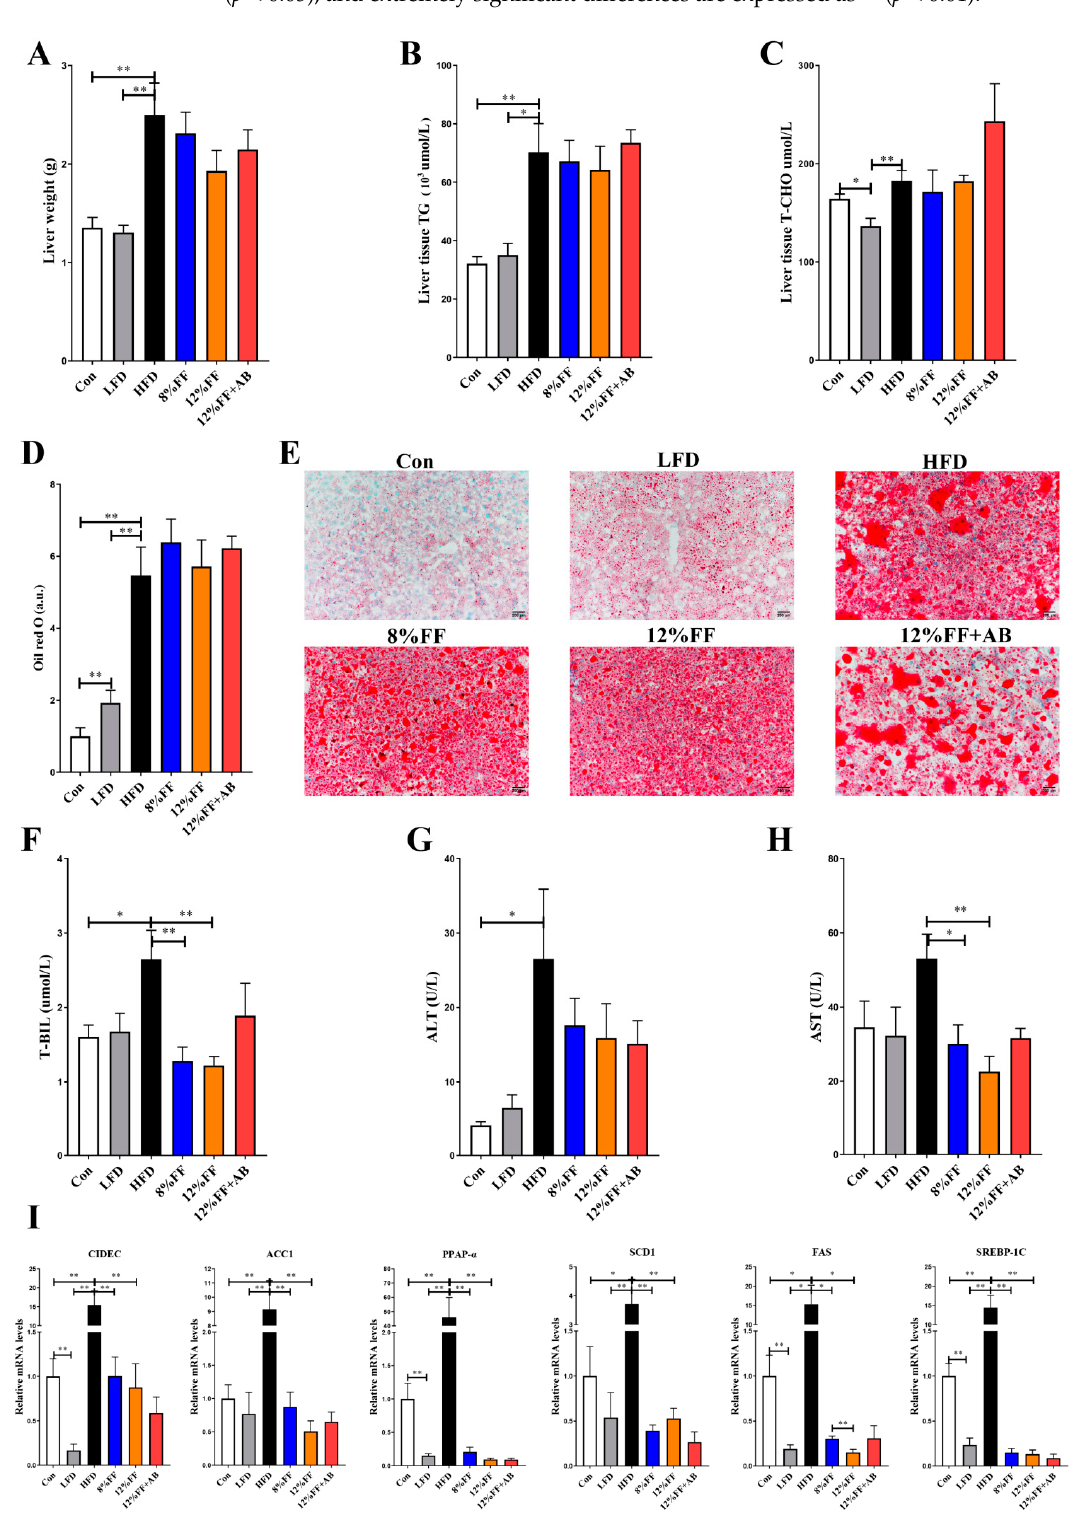
Figure 2. Effects of functional fiber on liver in obese mice ( n = 7). ( A ) Liver weight. ( B , C ) Liver triglycerides and total cholesterol. ( D , E ) Liver oil red O staining data. ( F ) Serum total bilirubin (T-BIL). ( G ) Serum alanine aminotransferase (ALT). ( H ) Serum aspartate aminotransferase (AST). ( I ) mRNA